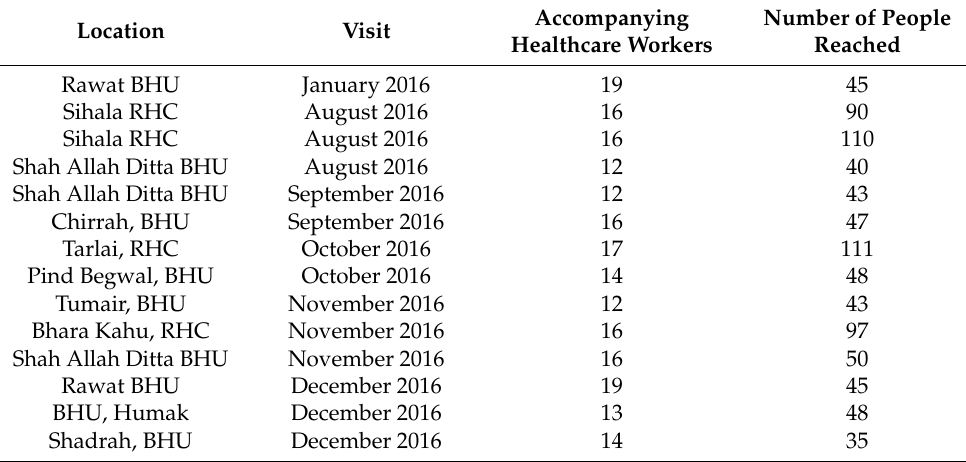
Table 3. The activities carried out in rural Islamabad in 2016.